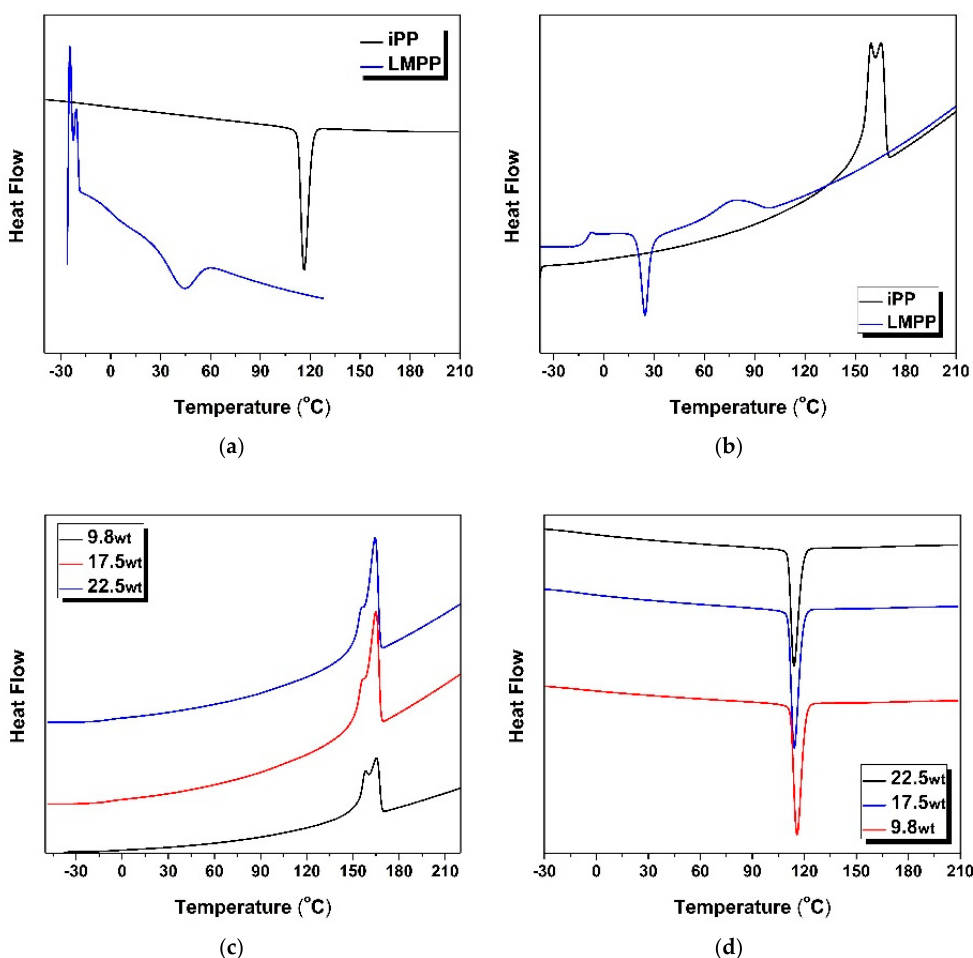
Figure 5. DSC curves with ( a ) second-heating curve and ( b ) second-cooling curve for pure iPP and LMPP, including ( c ) second-heating curve and ( d ) second-cooling curves for iPP/LMPP blends percentage suggested by the RSM model.